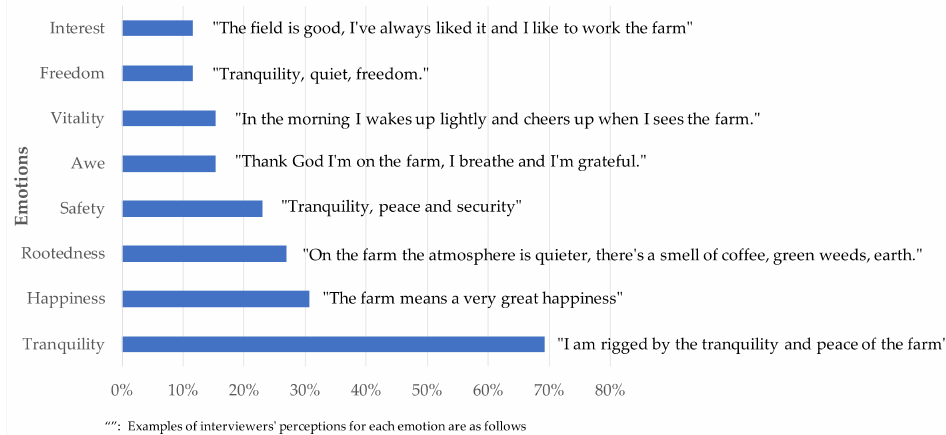
Figure 5. Recognition of emotions generated by living on the farm.